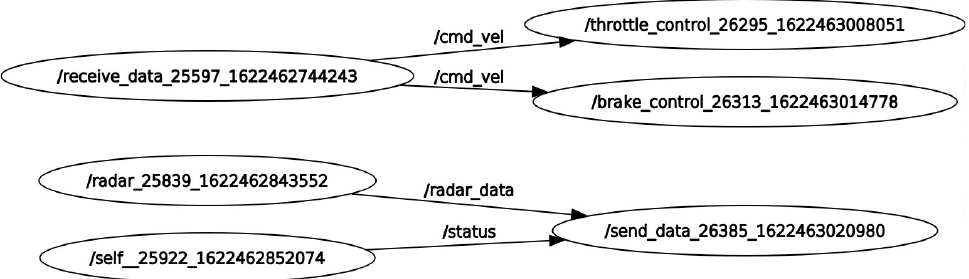
Figure 6. The ROS nodes of the cooperative car-following system for ICVs.